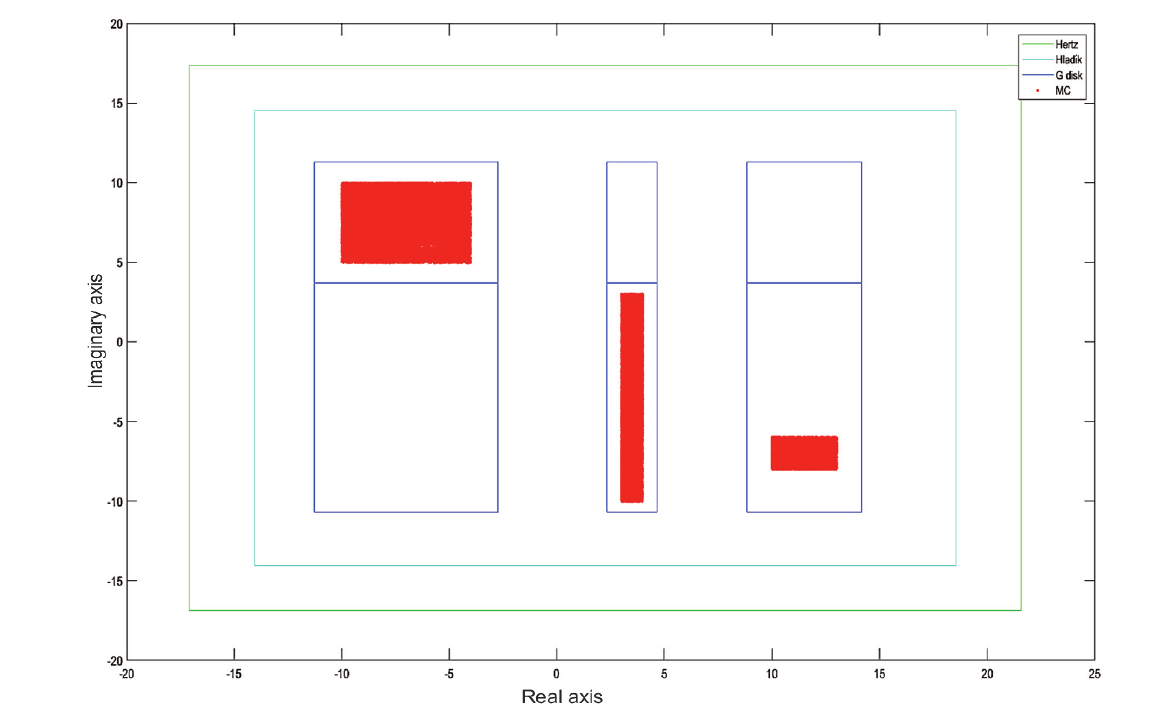
Fig. 5. Eigenvalue set and enclosures of Example